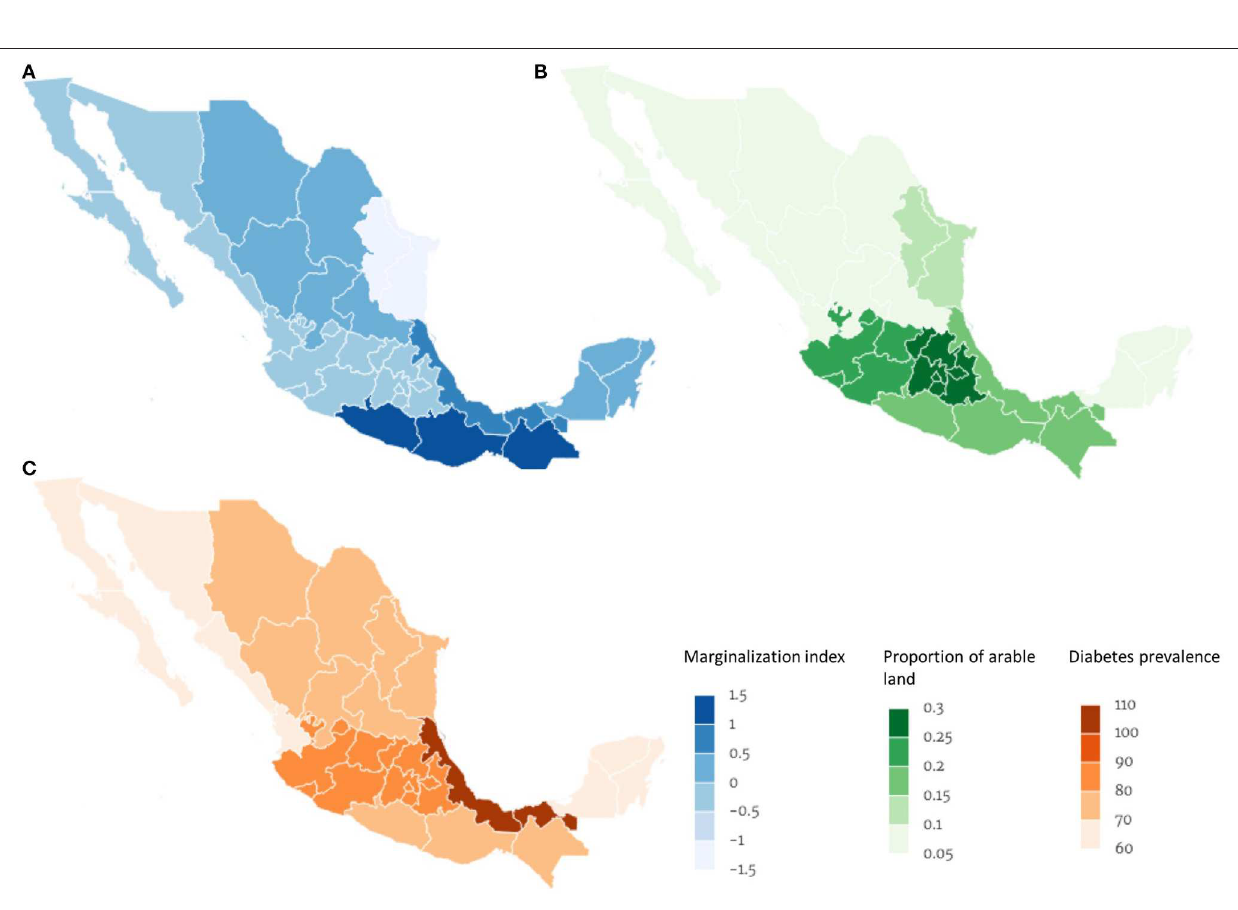
Frontiers in Sustainable Food Systems |